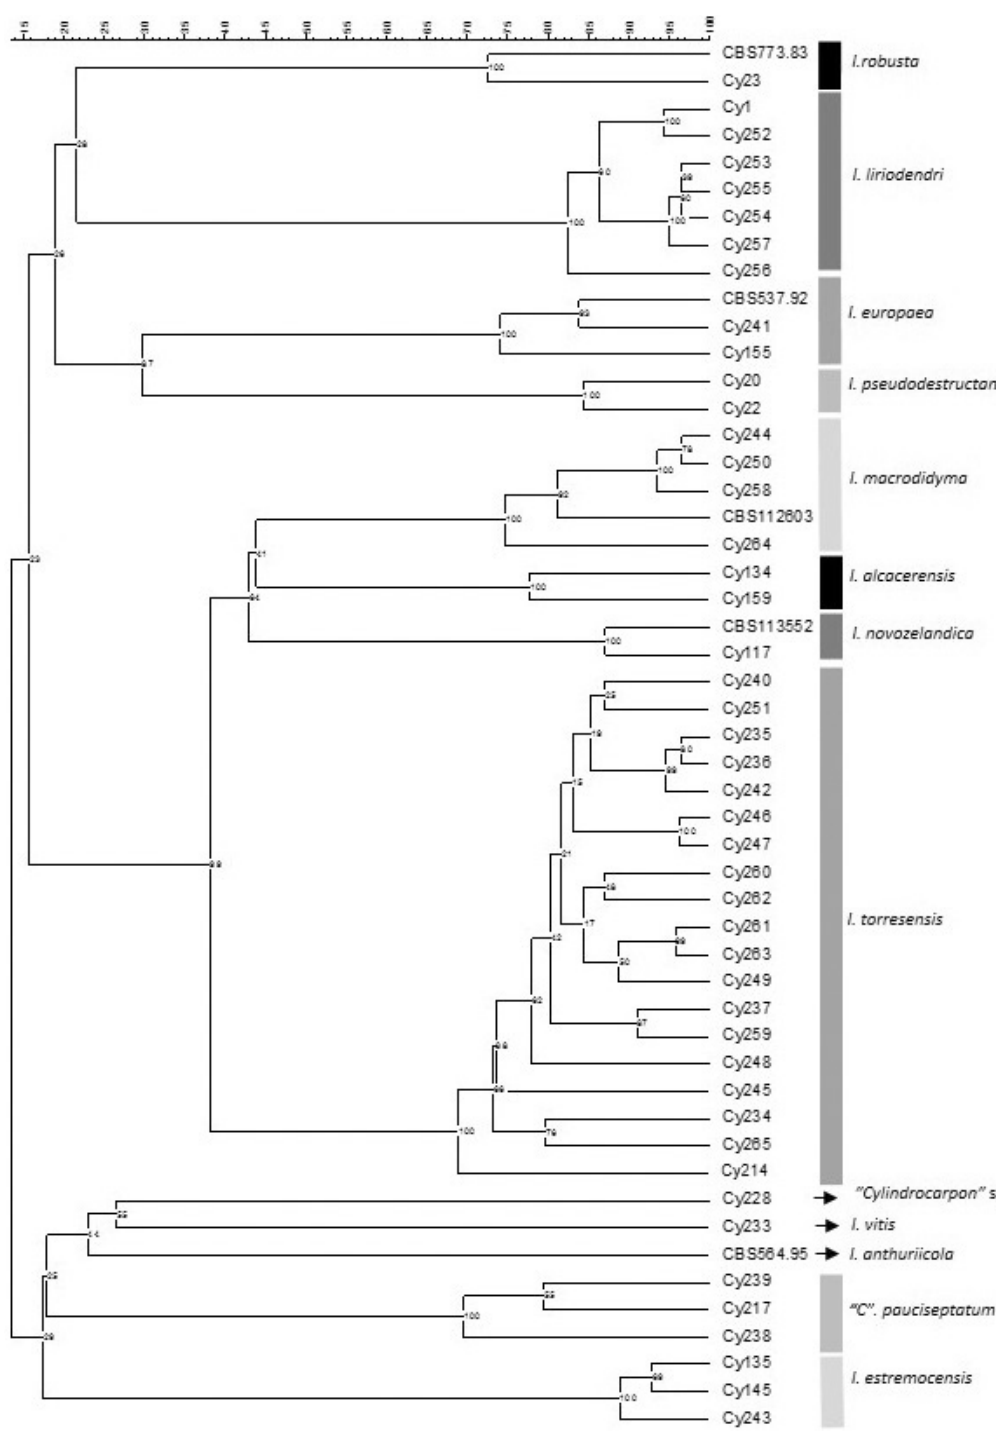
Figure 1. Dendrogram showing the diversity and relationships among Ilyonectria spp. and “ Cylindrocarpon ” spp . isolates based on cluster analysis (UPGMA) of a similarity matrix (Dice) generated from ISSR-PCR and RAPD-PCR profile data with four primers each. A total of 2,000 bootstrap replicates were